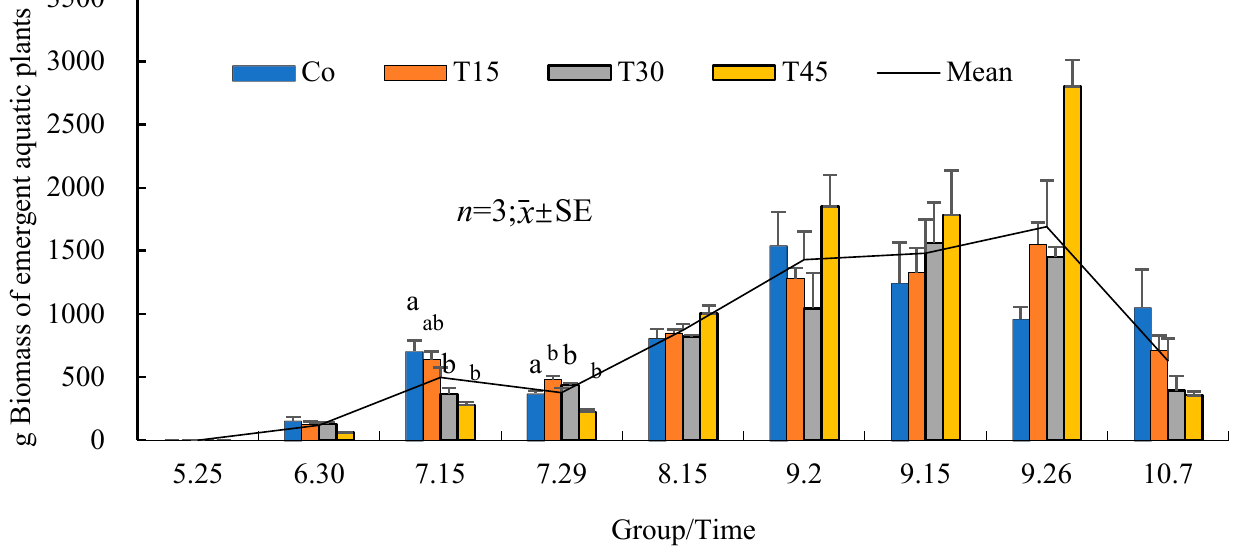
Figure 15. Biomass of the emergent aquatic plants in different treatment groups during the experiment. 3.6. Variations in the Benthic Animal Species and Quantities with Time The diversity and biomass of benthic animals in different treatment groups are shown